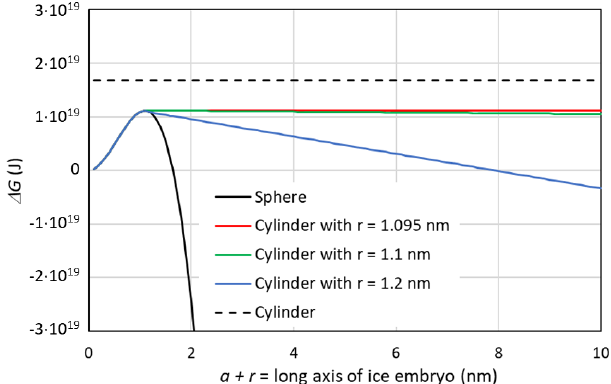
Figure 6. Gibbs free energy of a growing ice embryo calculated with CNT using the Ick15 parameterization for T = 230K and P 0 = 0 . 1MPa. The black solid line describes spherical growth of the ice embryo as expected in bulk water. The black dashed line gives (cid:49)G for the growth in length of a cylinder starting from a thin disk with radius r c = 1 . 095nm. The coloured lines show (cid:49)G for growth in cylindrical pores with radii available for free water of 1.095nm (critical value, red line), 1.1nm (green line), and 1.2nm (blue line), respectively.